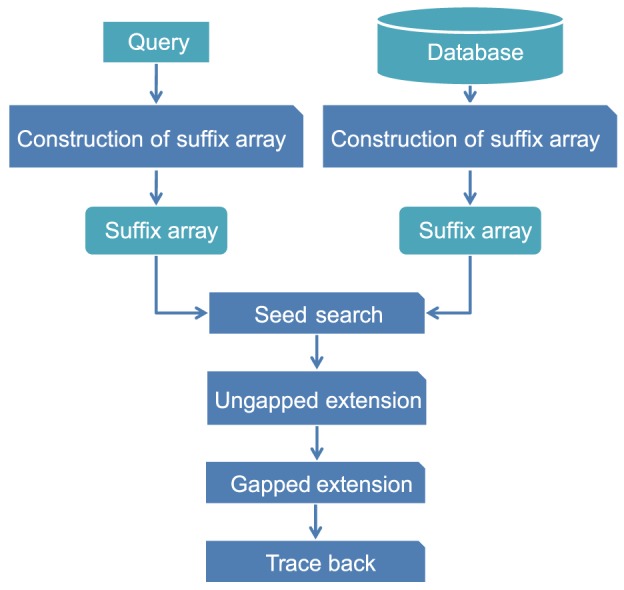
The flow of GHOSTX.